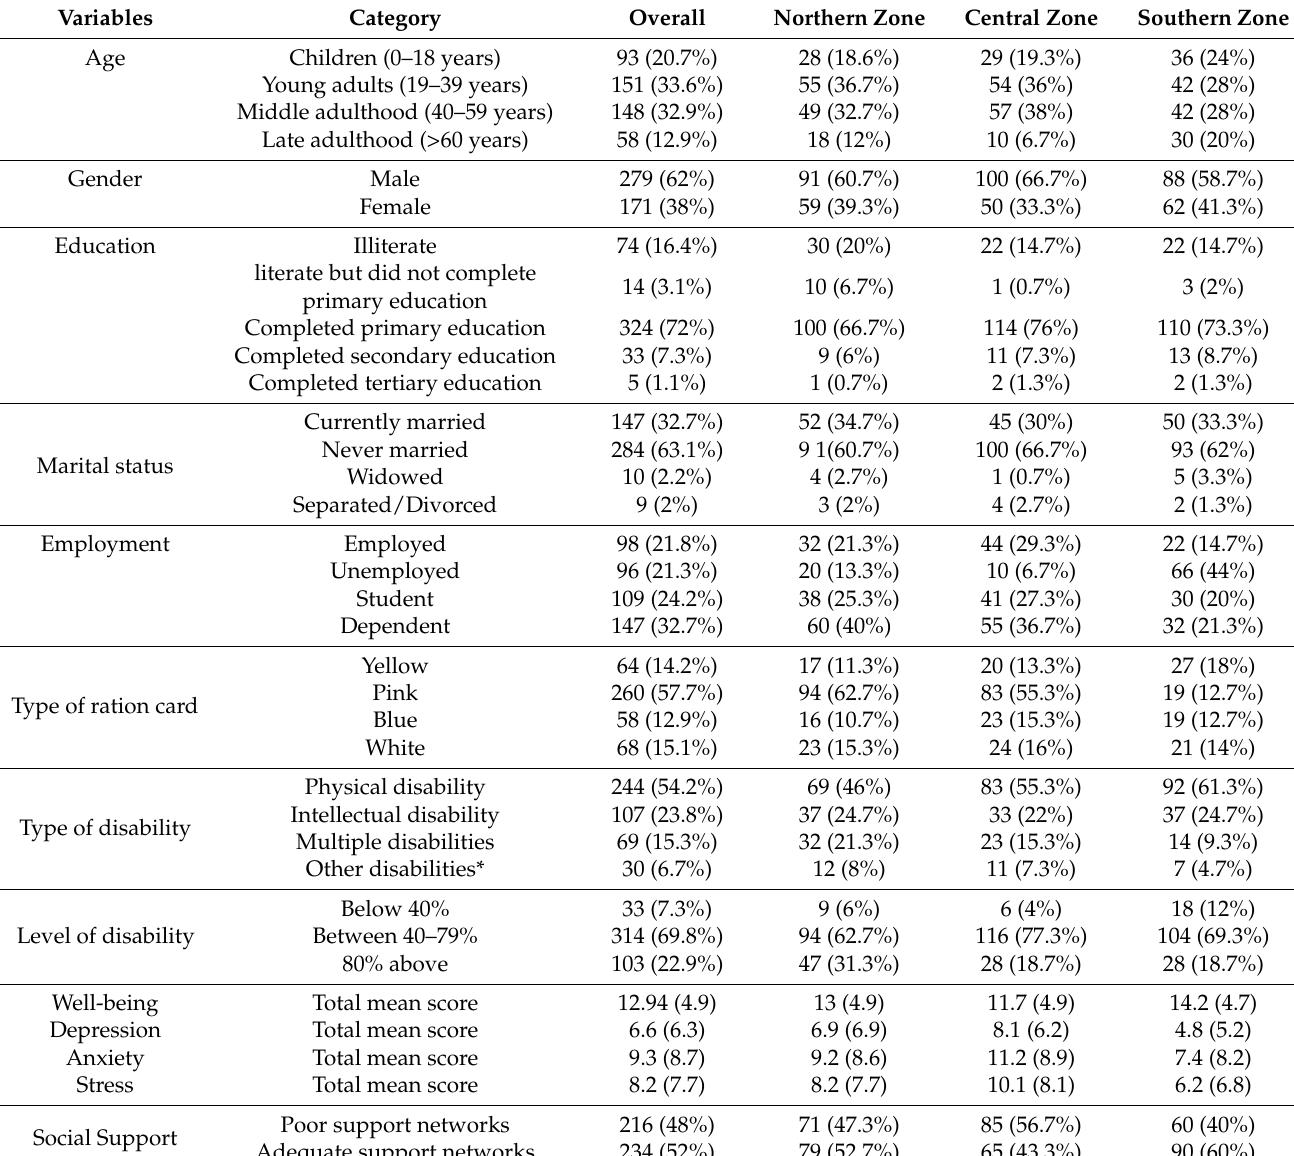
Table 1. Demographic Distribution of